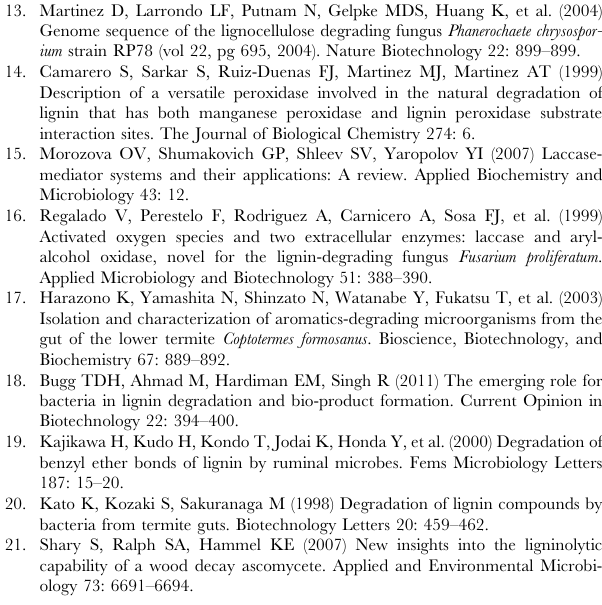
Table S2 Interpro annotation of proteins identified in MudPIT analysis. Table S3 KEGG annotations of proteins identified in MudPIT analysis. Table S4 Gene Ontology (GO) annotations of proteins identified in MudPIT analysis. Table S5 SignalP signal peptide prediction of proteins identified in MudPIT analysis. Table S6 Starvation and stress-related proteins from MudPIT analysis. Table S7 Proteins related to Host plant interaction from MudPIT analysis. Table S8 Hypothetical proteins detected from MudPIT